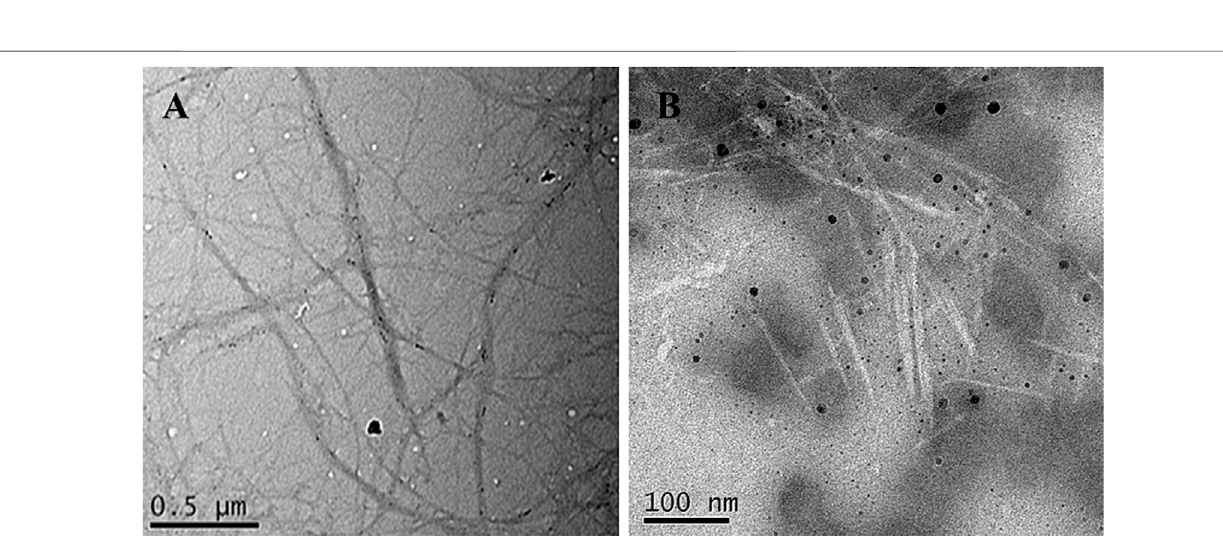
FIGURE 2 | TEM images of bamboo shoot NFC (A) and CNC (B)